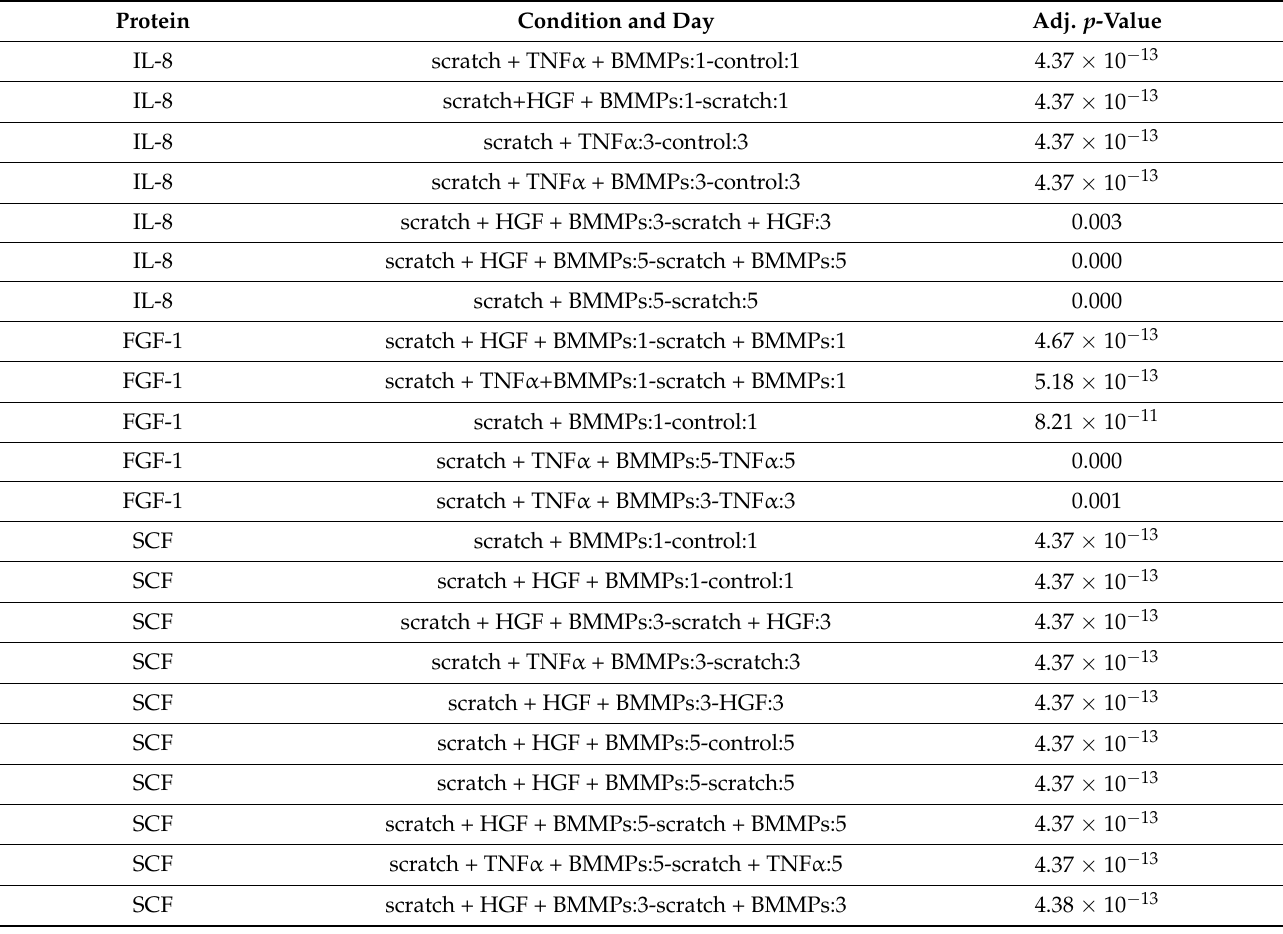
Table 2. The most statistically significant conditions plus time points for IL-8, FGF-1, and SCF